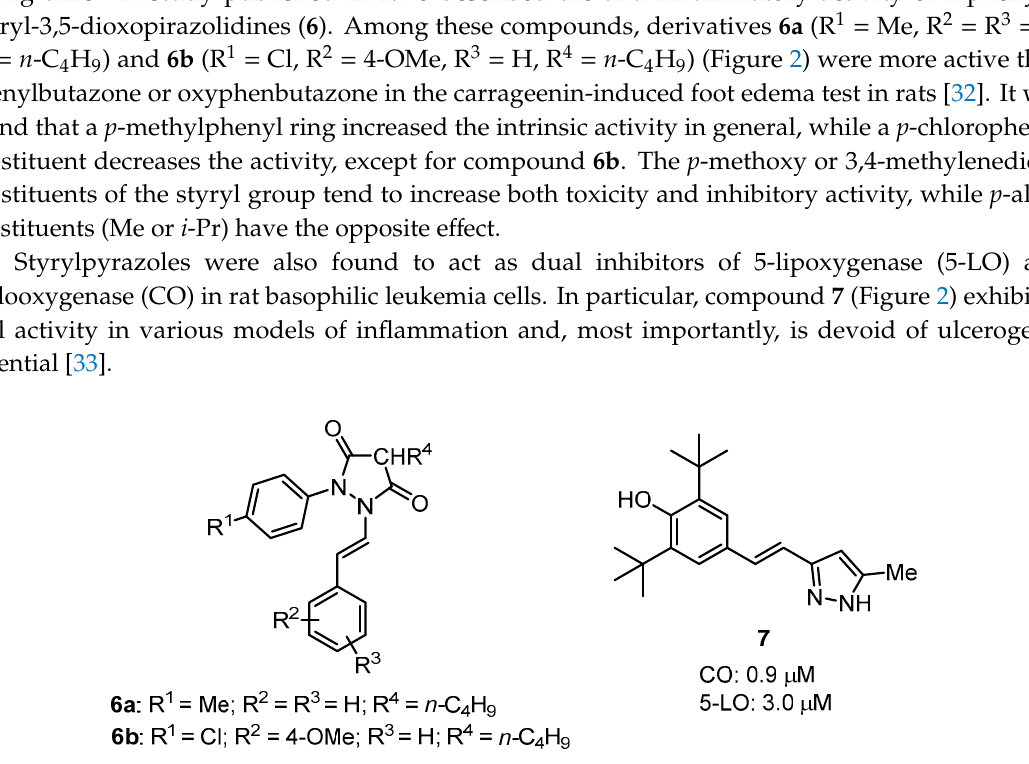
Figure 2. Styrylpyrazole derivatives 6 and 7 presenting anti-inflammatory activity